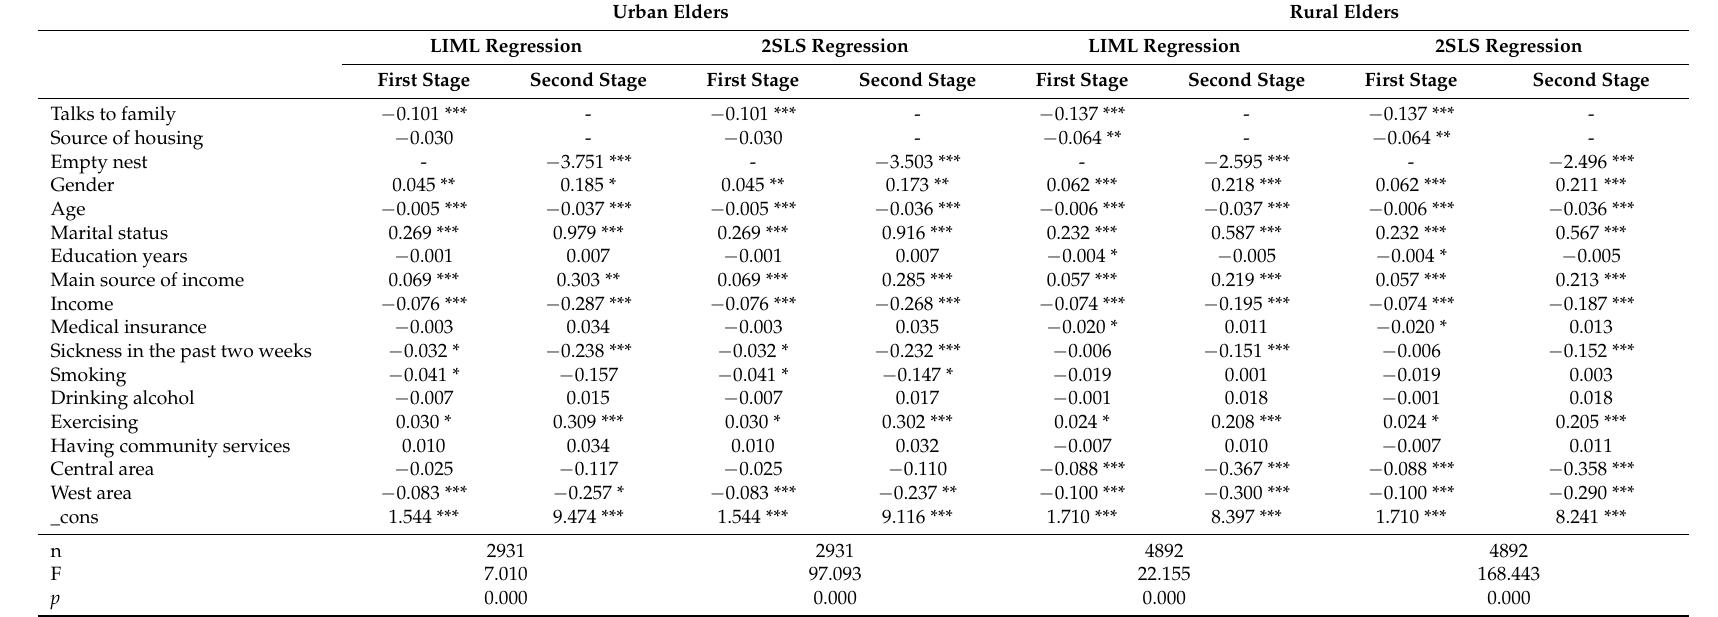
Table 5. Effects of an empty nest on urban and rural elders’ psychological health. Urban Elders Rural Elders LIML Regression 2SLS Regression LIML Regression 2SLS